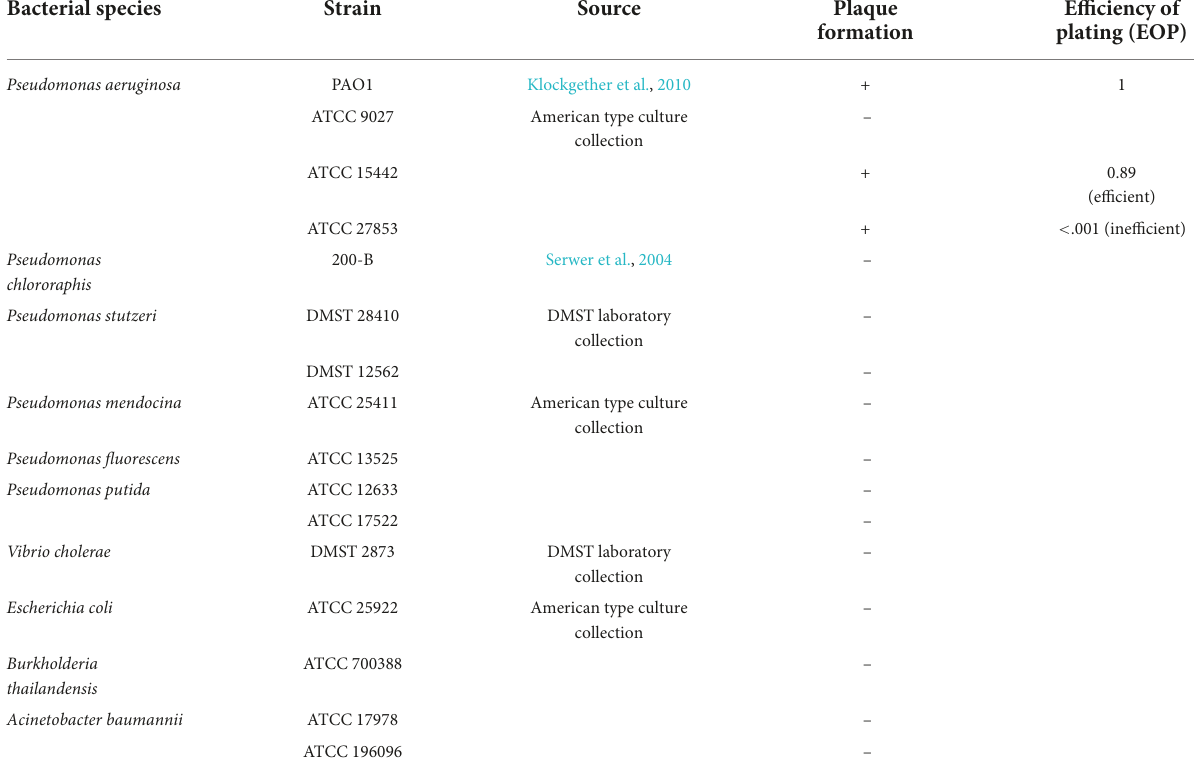
TABLE 1 Host range determination of phage